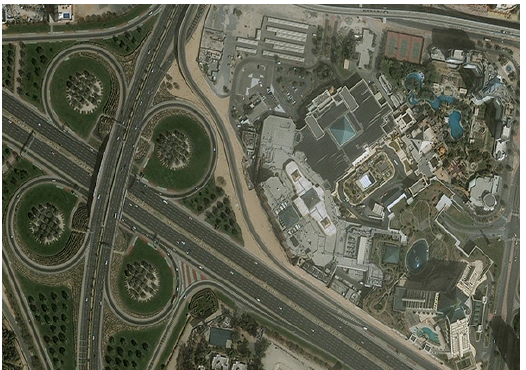
Figure 3: Quickbird(0.61m) RGB Image of Dubai, UAE (taken on February 2010)